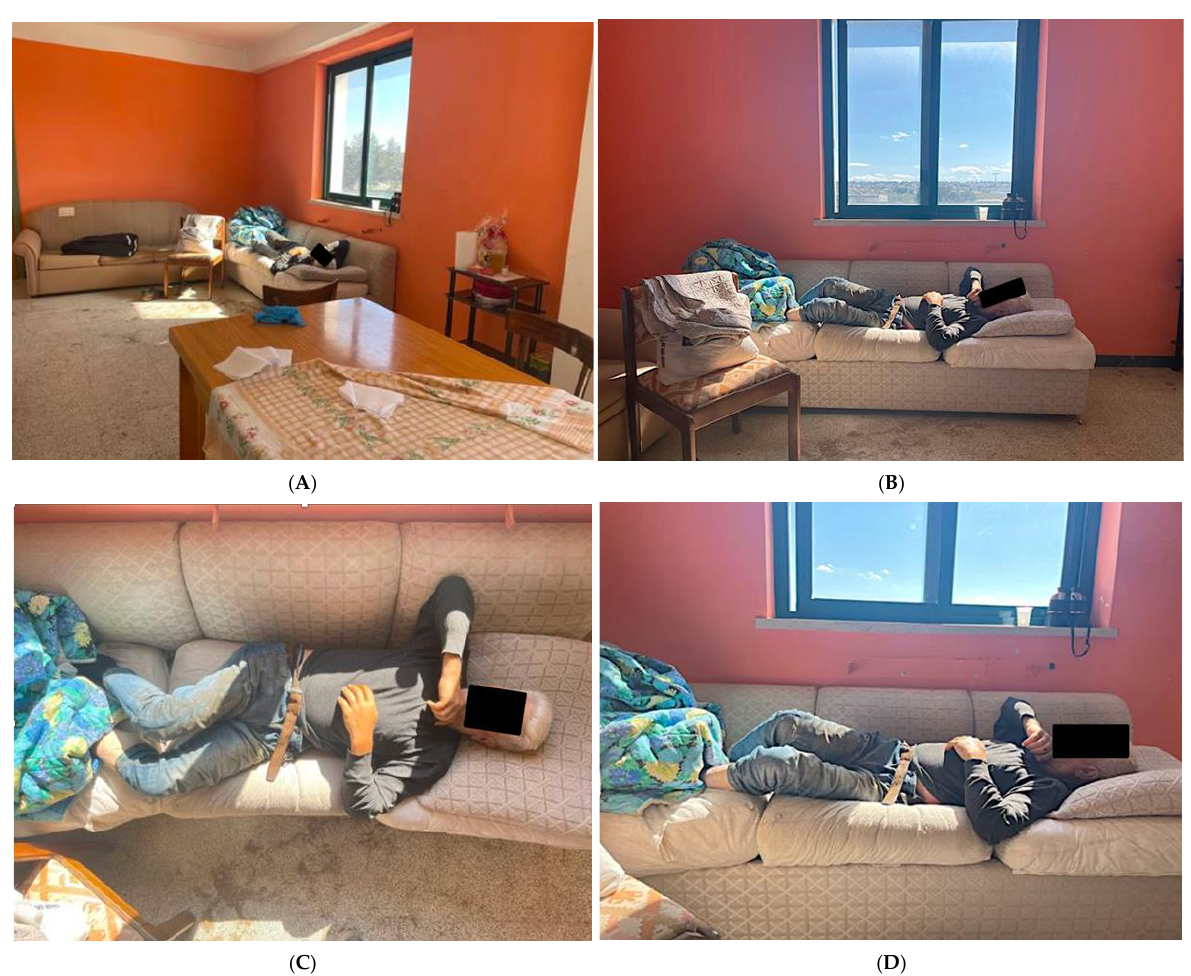
Figure 3. ( A – D ) Different views of the of the body found without life. (A) panoramic view; (B) lateral view; (C) view from top; (D) lateral view. view; ( C ) view from top; ( D ) lateral